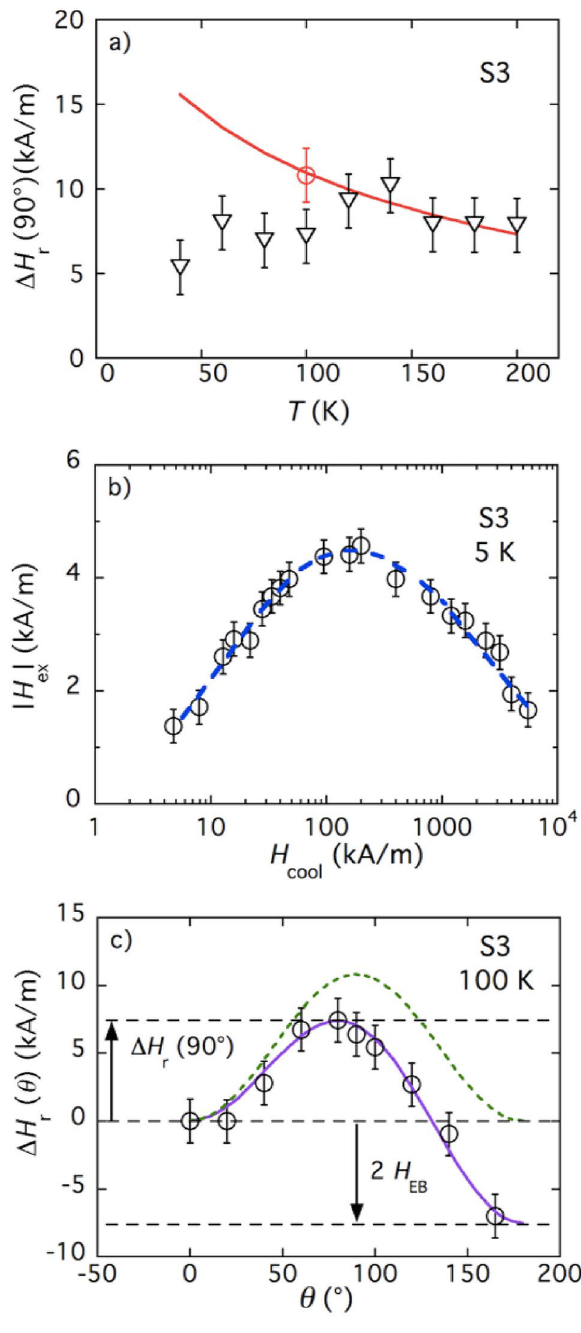
Figure 3. ( a ) Triangular symbols: thermal variations of � H r ( 90 ◦ ) , difference between FC-FMR fields obtained for θ = 90 ◦ and θ = 0 ◦ ), for textured sample S3; full line: adjustment of � H r ( 90 ◦ ) in the absence of H EB (see Eq. 2); red open circle: uniaxial contribution to � H 90 ◦ ) deduced from the fit of ( c ). ( b ) Cooling- r ( field dependence of the shift H ex of FC quasistatic hysteresis loops for non-textured sample S3. ( c ) Angular dependence of the resonance field shift � H r (θ) for textured sample S3 at T = 100 K; dashed line represents the angular variations of the uniaxial contribution; full line corresponds to the fit of the data by Eq. (4), see text for